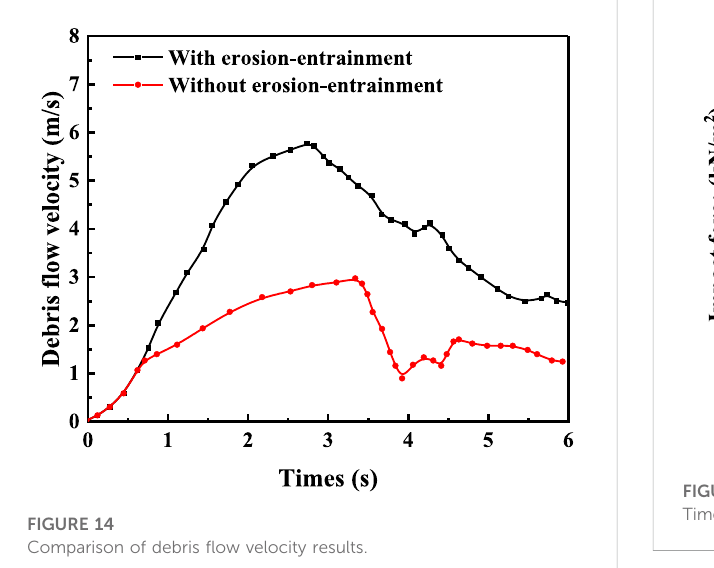
FIGURE 14 Comparison of debris fl ow velocity results.